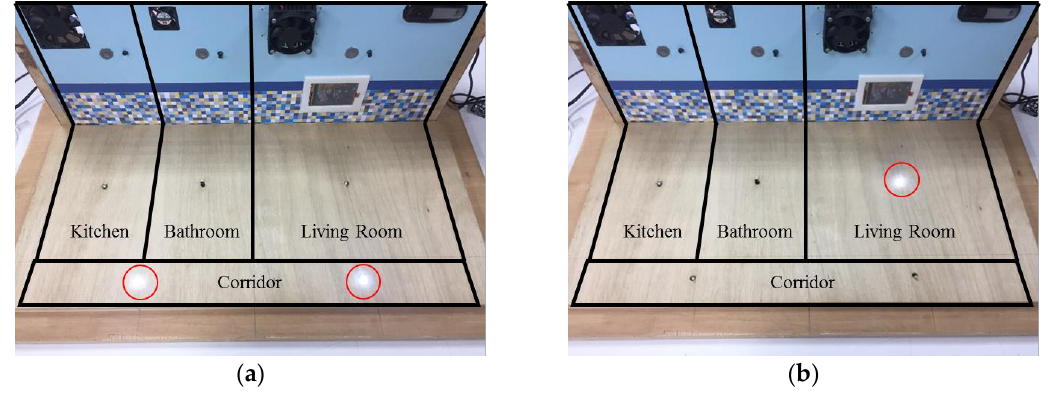
Figure 19. The statuses of the lights located in the experimental testbed when the resident left the corridor and walked into the living room based on the results shown in Figure 17. ( a ) Turn off the lights in the living room, kitchen, and bathroom, and turn on the lights in the corridor when the resident is in the corridor; ( b ) Turn off the lights in the kitchen, bathroom, and corridor, and turn on the lights in the living room when the resident is in the living room.